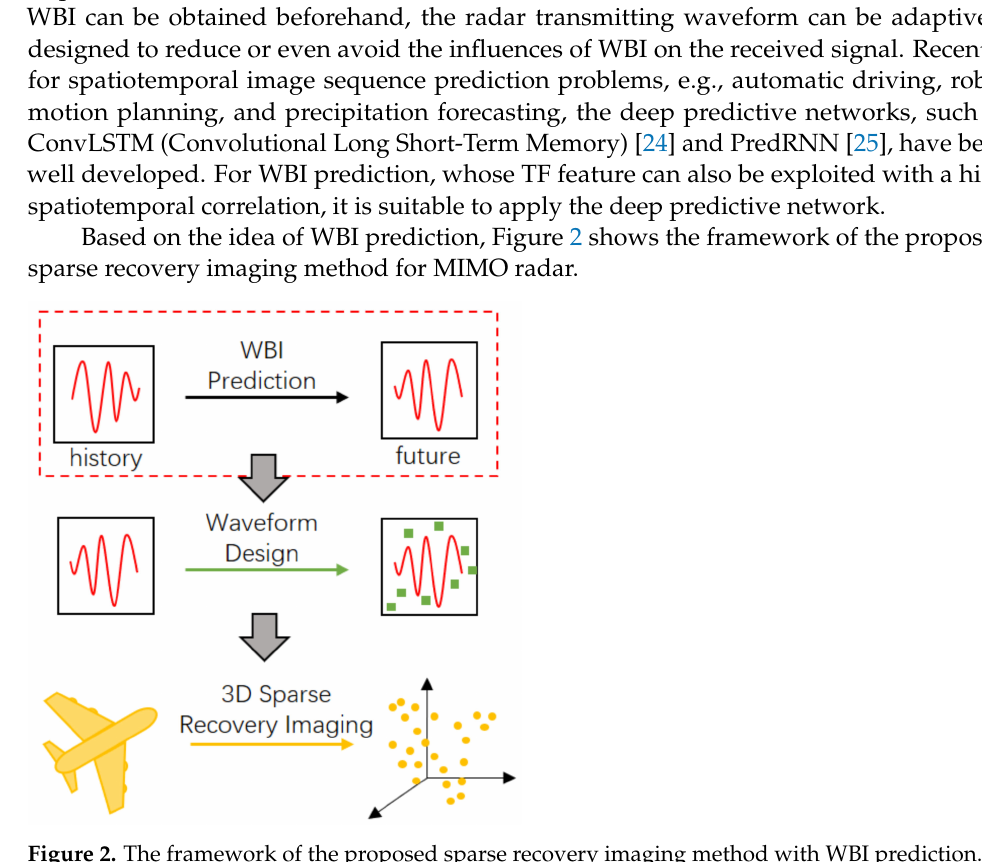
Figure 2. The framework of the proposed sparse recovery imaging method with WBI